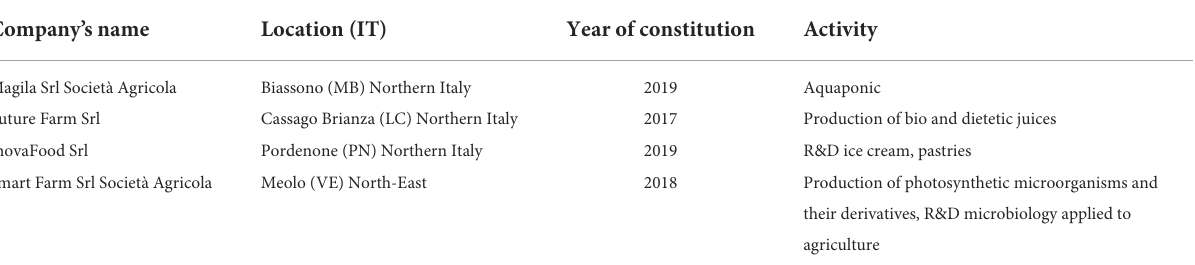
TABLE 1 The selected